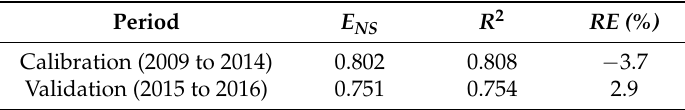
Figure 7. Simulated and observed monthly streamflow at Liancheng station during the calibration period 2009 to 2014 and the validation period 2015 to 2016. Table 1. The calibration and validation statistics.